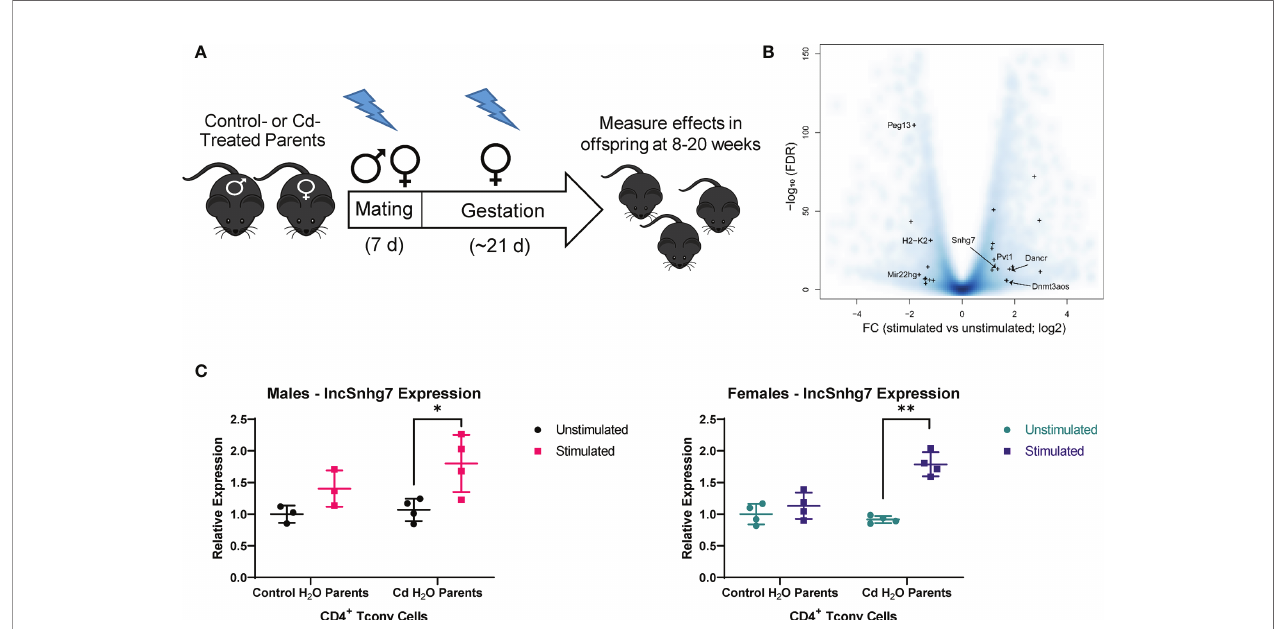
FIGURE 1 | lncSnhg7 expression is increased in CD4 + T cells with activation. (A) Mice were exposed to Cd during prenatal development. Lightning bolts indicate times where parents are administered CdCl 2 (10 ppm) via drinking water. (B) Volcano plot for the comparison of gene expression between unstimulated and stimulated CD4 + T cells. CD4 + CD25 - T conventional (T conv) cells were isolated from the total splenocytes of control offspring. T conv cells were cultured for 0 or 16 hours in the presence of anti-CD3/CD28 magnetic beads, unstimulated and stimulated, respectively. RNA was isolated and expression was analyzed by RNAseq. Blue background represents all genes (coding and non-coding). “ + ” indicates lncRNAs detected as differentially expressed in our system (FC > 2 and FDR < 0.01). (C) LncSnhg7 expression is increased in male and female activated CD4 + T cells. CD4 + CD25 - T conventional (T conv) cells were isolated from control and Cd- exposed offspring and stimulated as in (B) LncSnhg7 expression was evaluated by qPCR. Statistical signi fi cance was assessed using one-tailed, paired t-test between stimulated and unstimulated samples. *p < 0.05, **p < 0.01. n=3-4 per